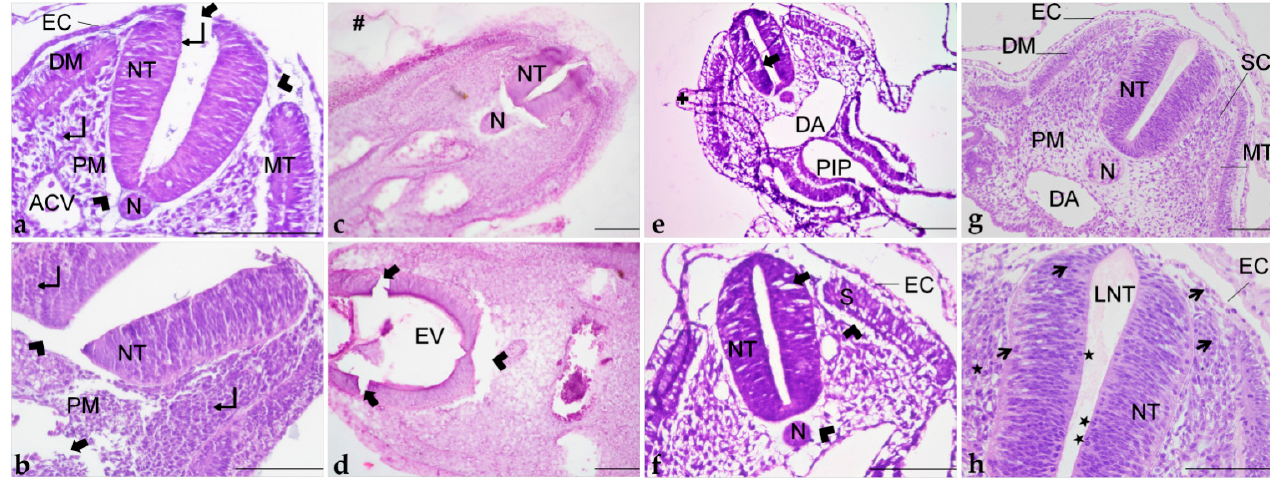
Figure 9. Histological sections of embryos embedded in paraplast ( a , b ); paraplast with pre-embedding in agar–gelatin ( c , d ); PEG ( e , f ); and historesin ( g , h ). ACV: Anterior cardinal vein. DA: Dorsal aorta. DM: Dermatome. EC: Ectoderm. EV: Encephalic vesicle. LNT: Lumen of the neural tube. MT: Myotome. N: Notochord. NT: Neural tube. PM: Paraxial mesoderm. PIP: Posterior intestinal portal. S: Somite. SC: Sclerotome. +: Detachment. #: Agar–gelatin residue. ★ : Mitotic figures. ↵ : Nucleus. Arrowhead: Shrinkage. Thicker arrow: Disruption. Thinner arrow: Evident nucleus and nucleolus. Staining: H&E. Scale bar = 100 µm.